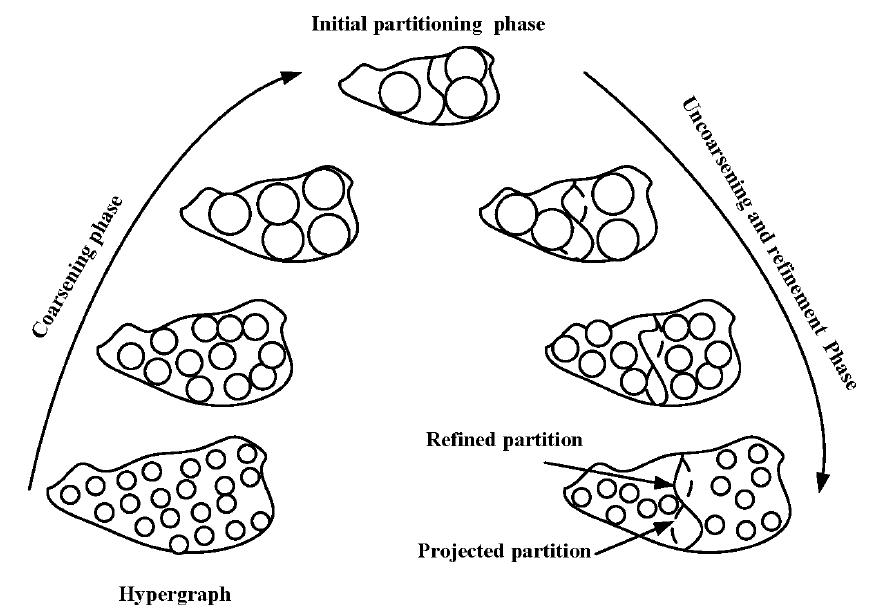
Figure 5. An example of multilevel partitioning